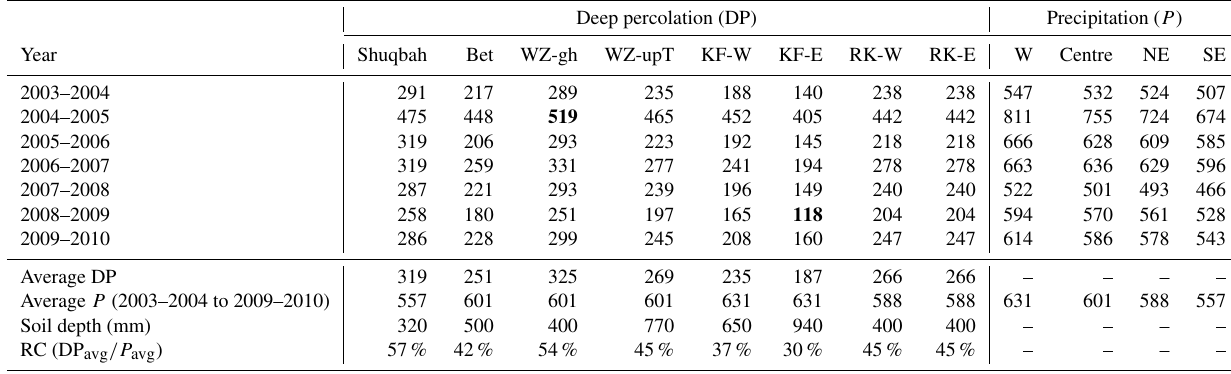
The table shows area precipitation of the respective sub-catchments of the SM stations (from Messerschmid et al., 2018). West (W) uses the average rain of the Ne’alin and Shibteen-1 sub-catchments. Centre refers to the average between Shibteen-1 and Wadi Zarqa. Northeast (NE) is the precipitation in Wadi Zarqa. Southeast (SE) represents the average of the Shibteen-2 and Ein Ayoub catchments (Fig. 4). The daily rates of deep percolation were modelled with these area precipitation values. Minimum and maximum values of DP are bold (WZ-gh in 2004–2005; KF-E in 2008–2009). All units are in mma − 1 , except for the soil depth (mm) and recharge coefficients (expressed as DP avg /P avg as a